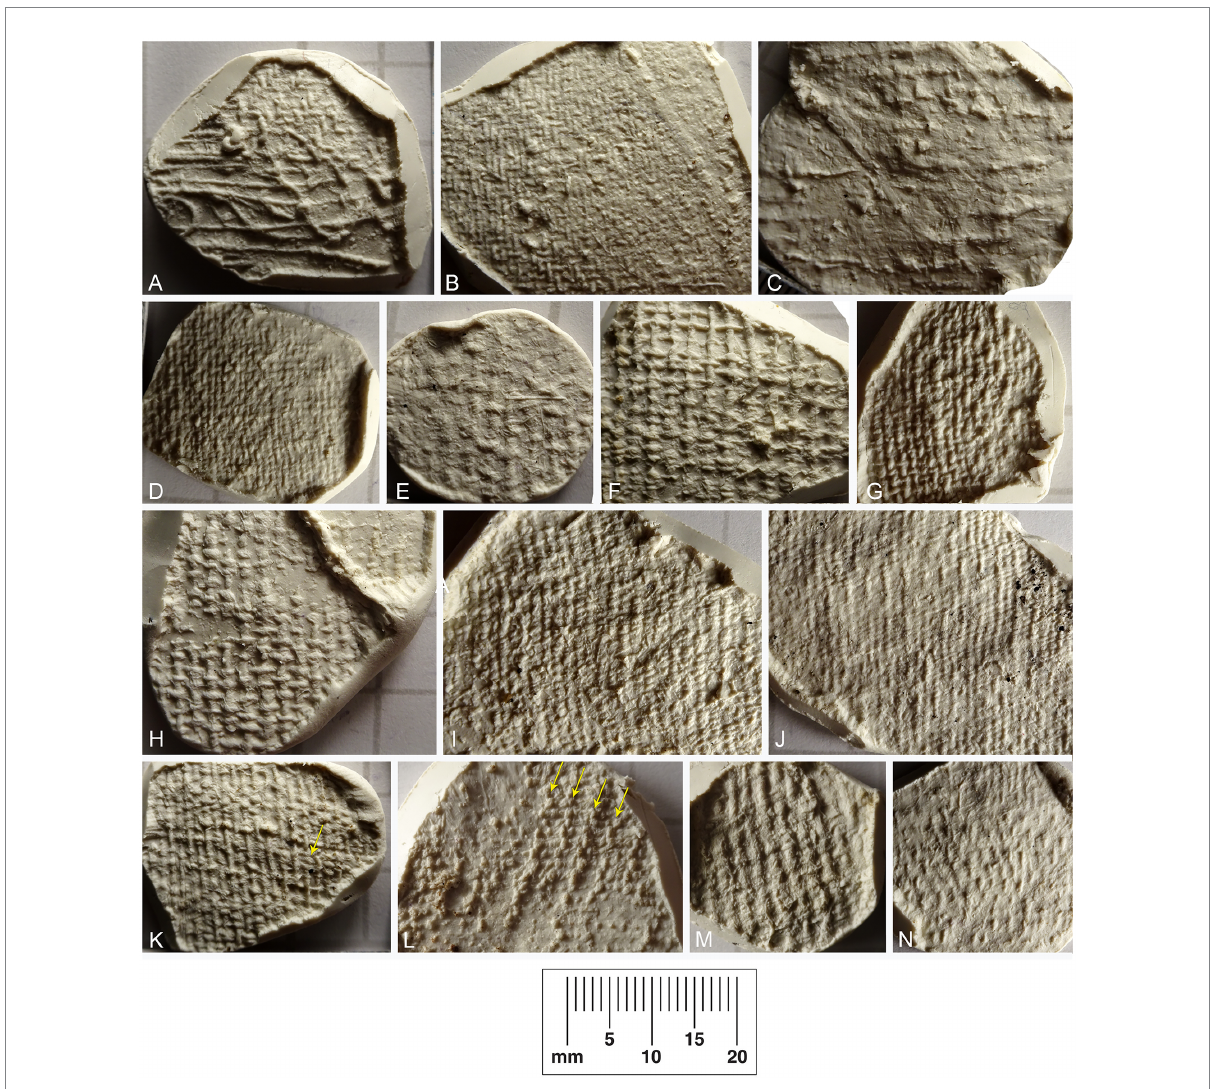
FIGURE 2 The different weaves from Chap 1. (A,B) = 2/2 twills with a frayed edge. (C–H) = various tabby structures. (I–L) = repp ( K shows multiple wefts grouped in an irregular pattern. (L) shows a ‘ribbed’ texture created by alternating between compacted wefts and open areas that expose the warp). (M,N) = possible hand-twined